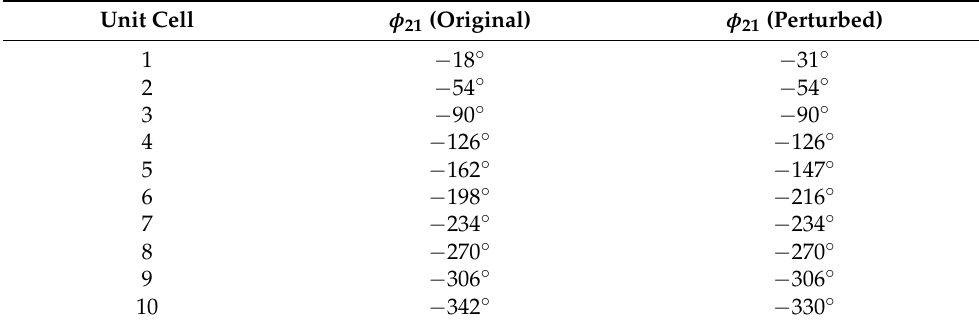
Table 1. The unit cell transmission phases ( φ 21 ) used in the design of the gradient metasurface for plane wave refraction. The original phase gradient corresponds to the linear phase gradient. The perturbed phase gradient corresponds to the adjusted phases used to improve the performance of the